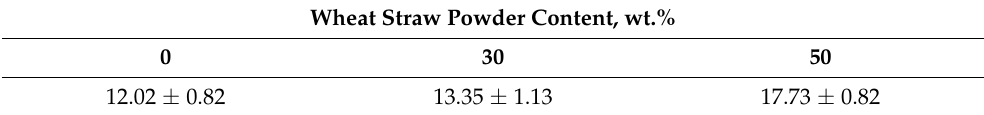
Table 5. Microhardness of composites using Vickers method (HV).